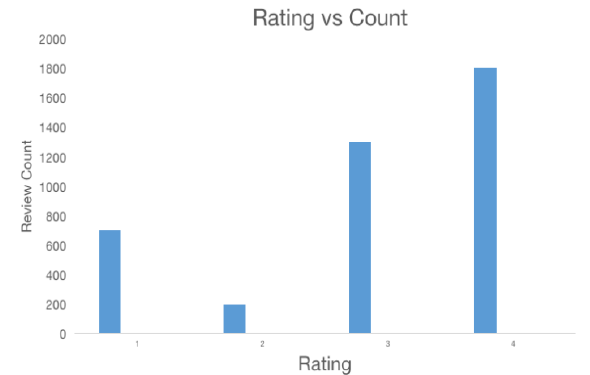
Fig. 4. Product rating v/s Count of